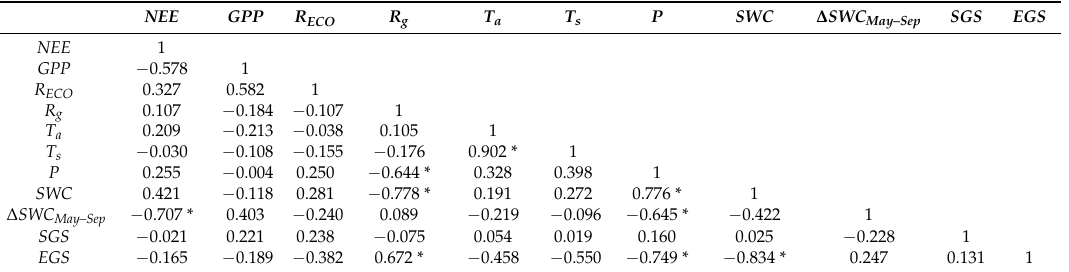
Table A6. Correlation coefficients for the main annual fluxes ( NEE , GPP , R ECO ) and the mean annual values of the main driver variables ( R g —global radiation, T a —air temperature, T s —soil temperature, P —precipitation, SWC —soil water content, ∆ SWC May - Sep —difference of the mean monthly SWC in May and SWC in September, SGS and EGS —day of year for the start and the end of the growing season, respectively). Significant ( p < 0.05) coefficients are marked with